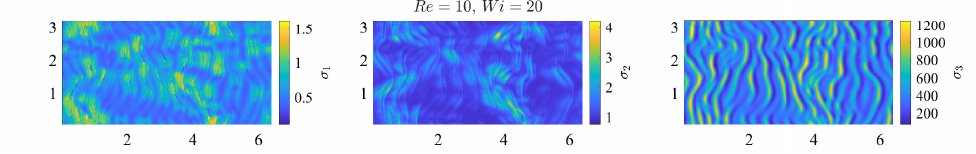
Figure 15. Contour of eigenvalues in the x – z plane at channel center y = δ for Re = 10 and Wi = 20.